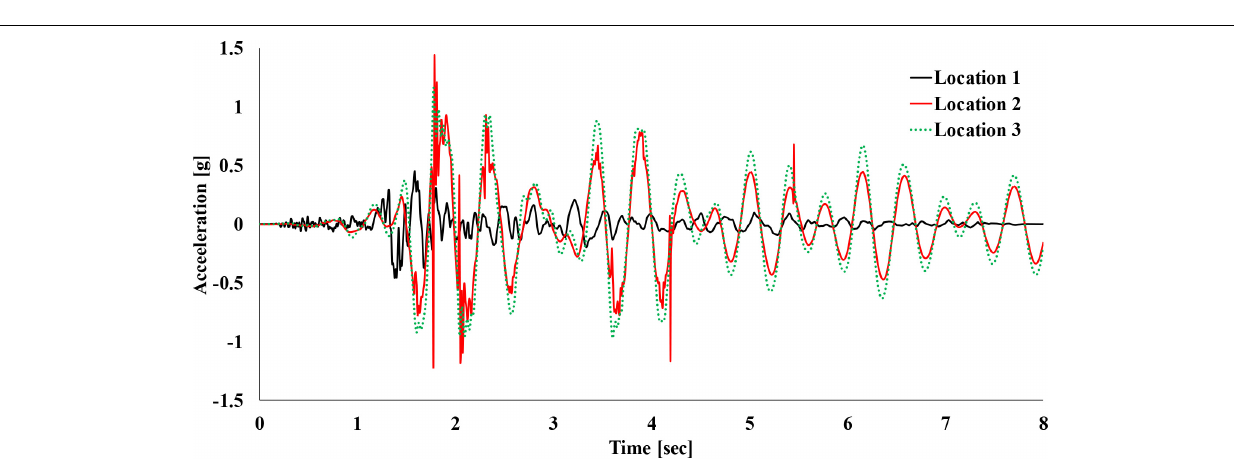
Frontiers in Built Environment |